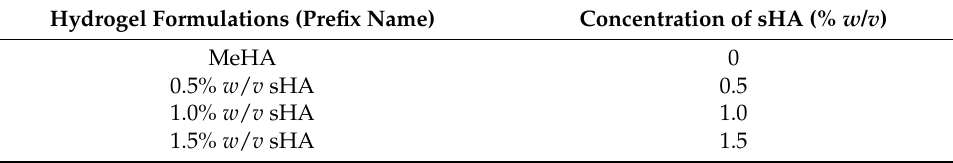
Table 1. Concentration of sHA in hydrogel. Hydrogel Formulations (Prefix